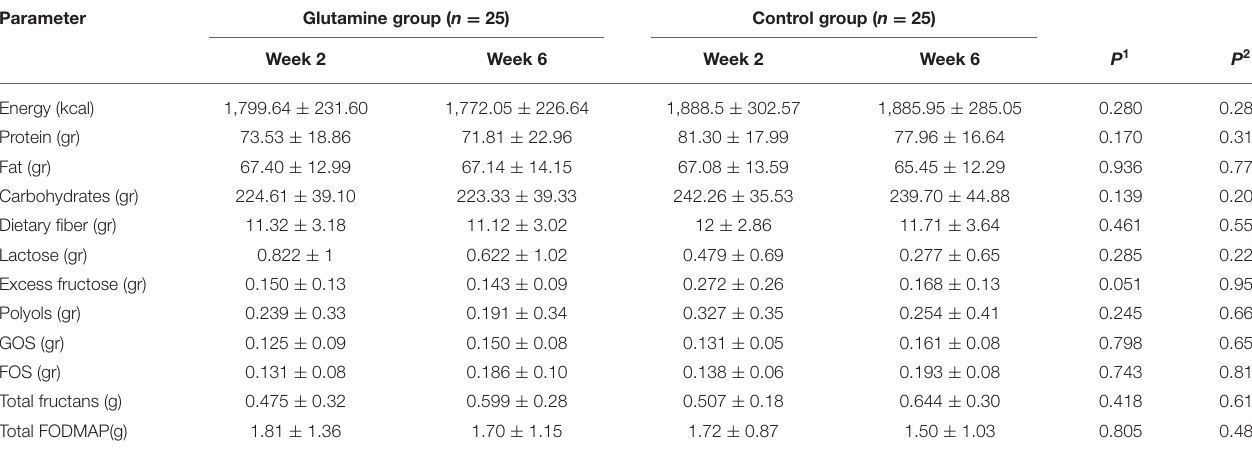
TABLE 2 | The mean daily nutrition information during the study in intervention groups. Parameter